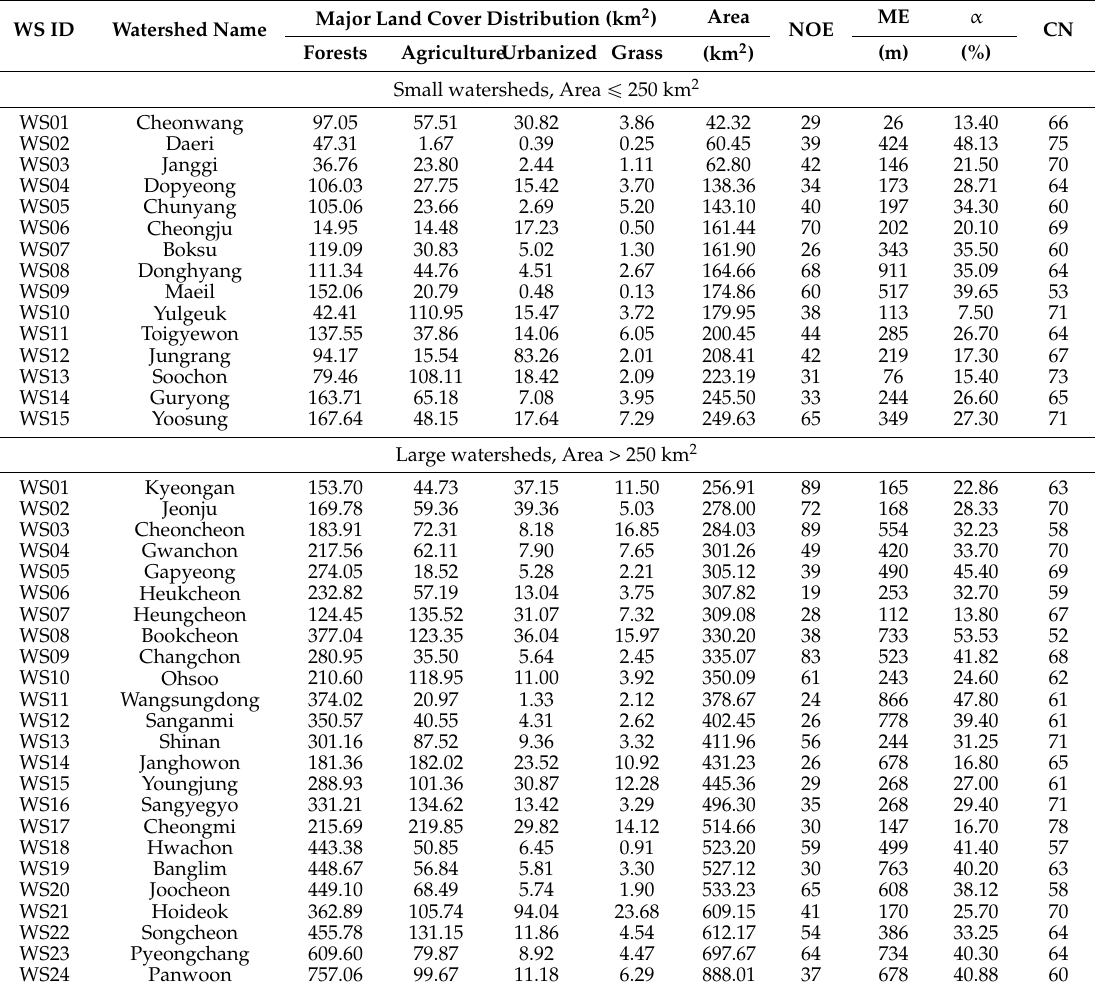
Table 1. Watersheds and data description.